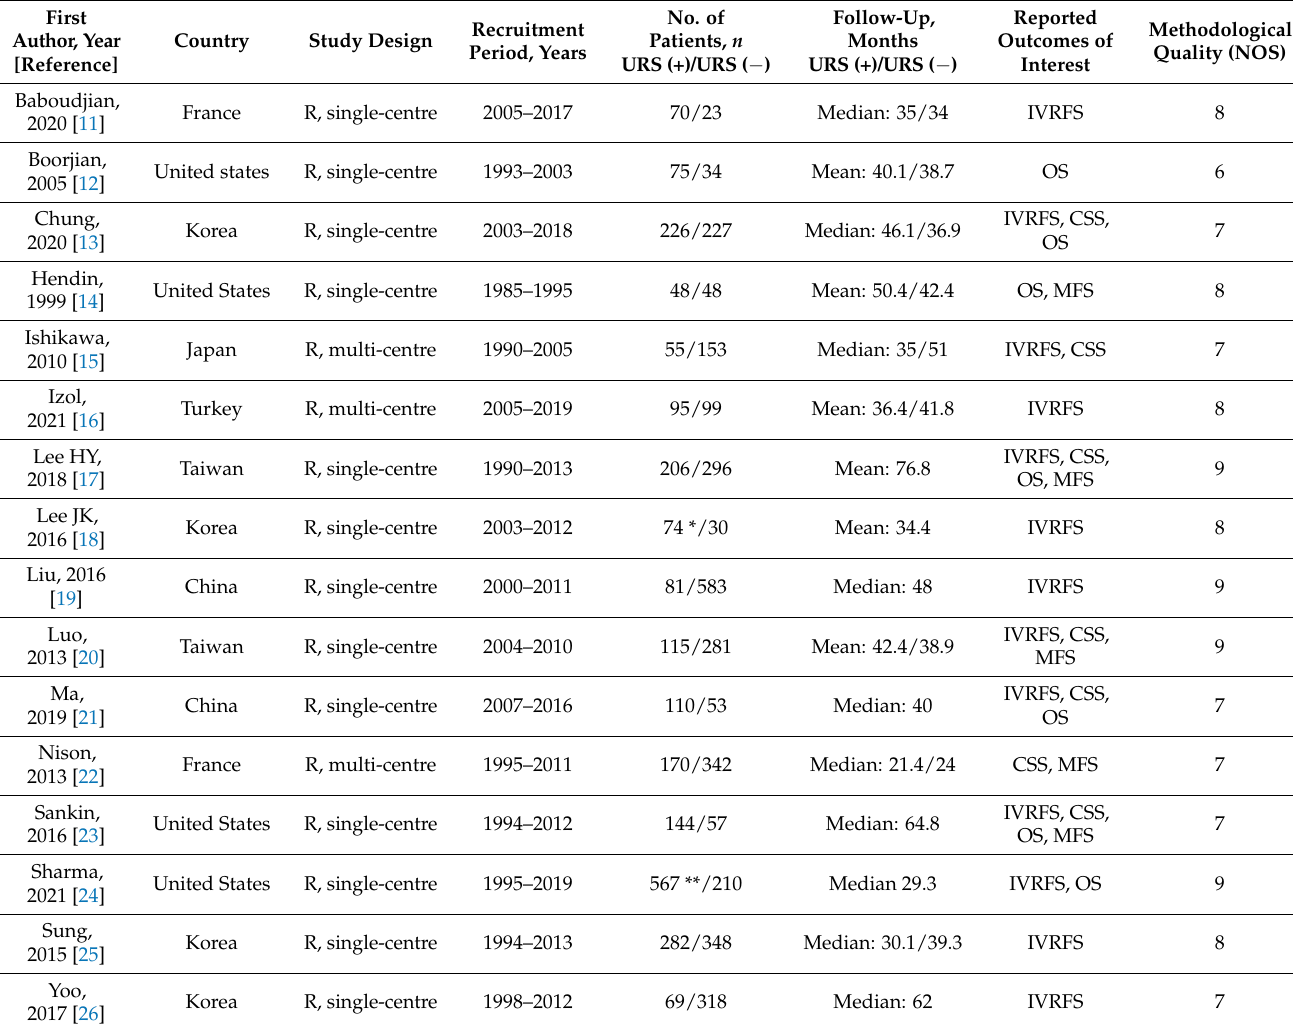
Table 1. Baseline characteristics and quality assessment of included